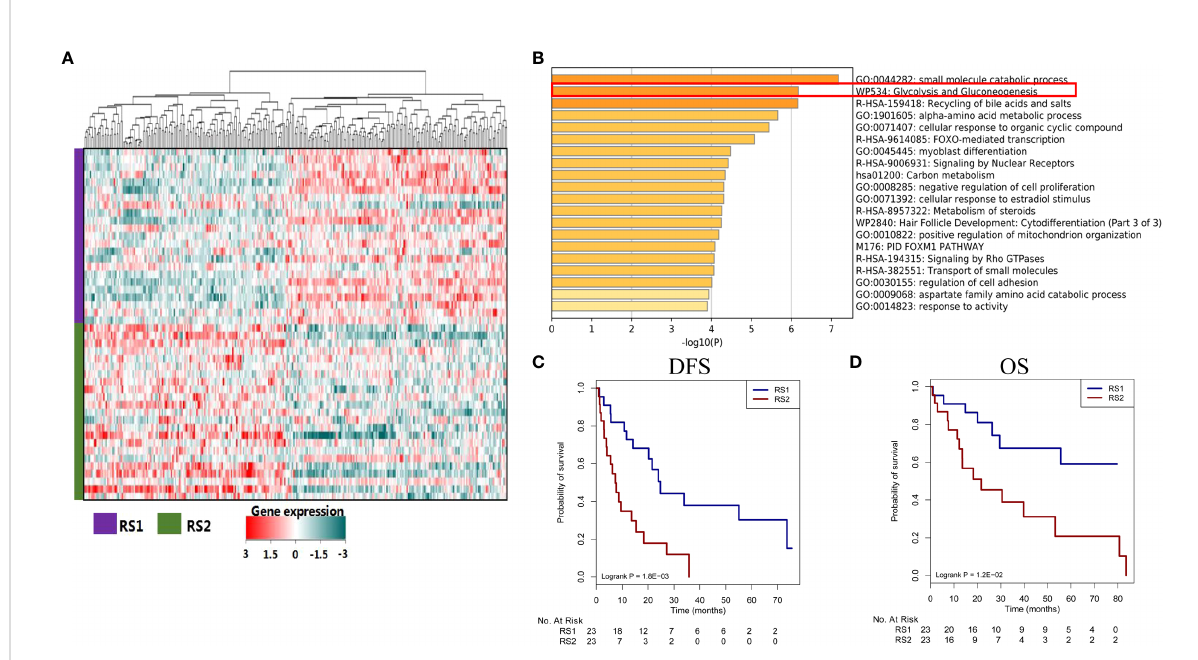
FIGURE 6 Different genes, signaling pathways, and prognosis associated with predicted treatment response. (A) The heat map plot of mRNA expression from different genes. Patients with HCC are shown on the y -axis, and gene expression is shown on the x -axis. (B) Some genes are enriched in certain signaling pathways, such as in the glycolysis and gluconeogenesis pathways. (C, D) The responder group shows better DFS and OS than the non-responder group does. HCC, hepatocellular carcinoma; DFS, disease-free survival; OS, overall